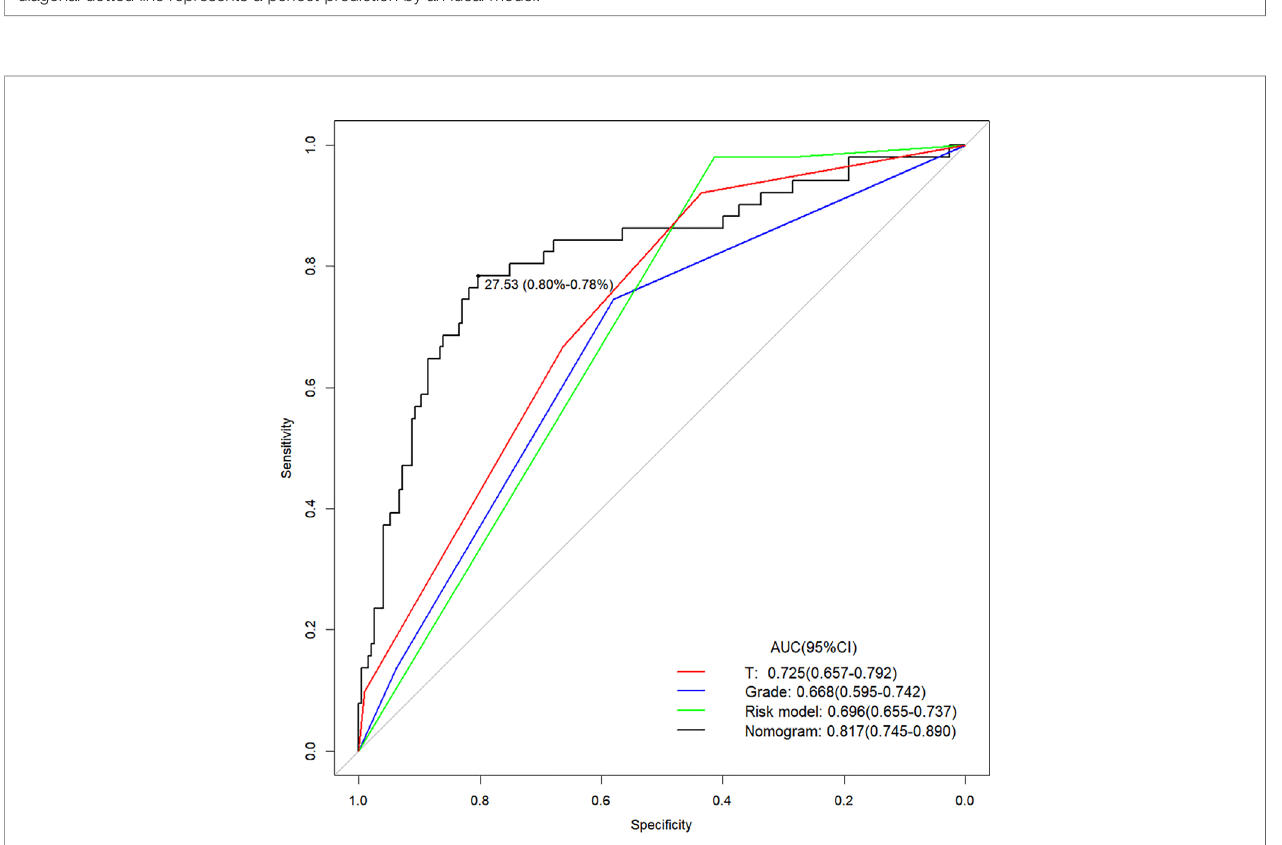
FIGURE 4 | The Area Under Curve (AUC) of the prediction nomogram on T, Grade, Risk model and nomogram. T, tumor stage.